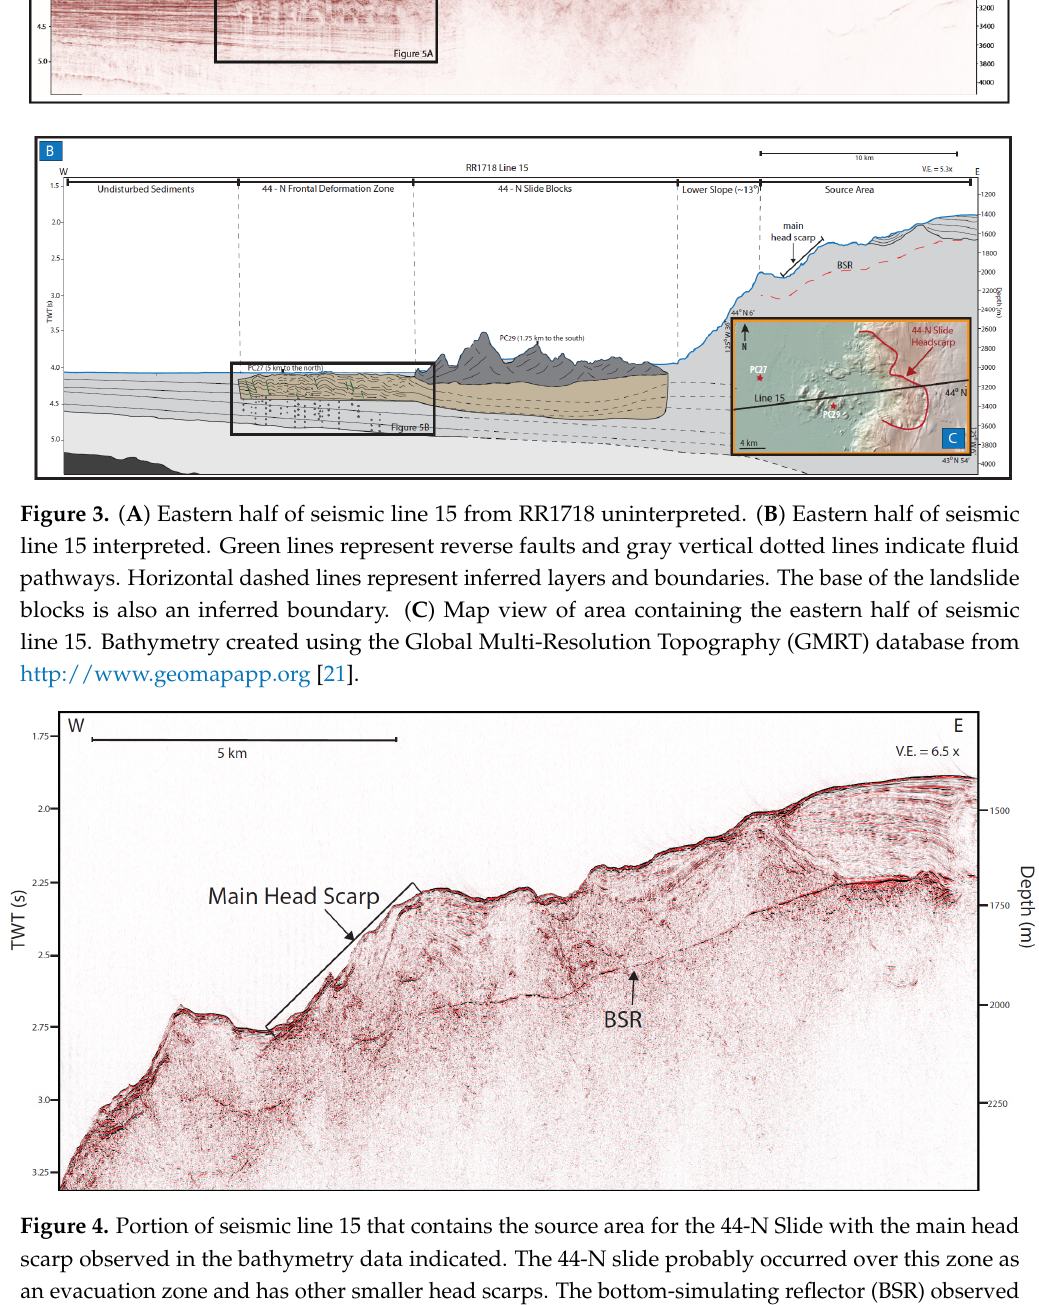
Figure 4. Portion of seismic line 15 that contains the source area for the 44-N Slide with the main head scarp observed in the bathymetry data indicated. The 44-N slide probably occurred over this zone as an evacuation zone and has other smaller head scarps. The bottom-simulating reflector (BSR) observed can be interpreted as the presence of gas hydrate. A BSR can be seen beneath the source area of the 44-N slide.